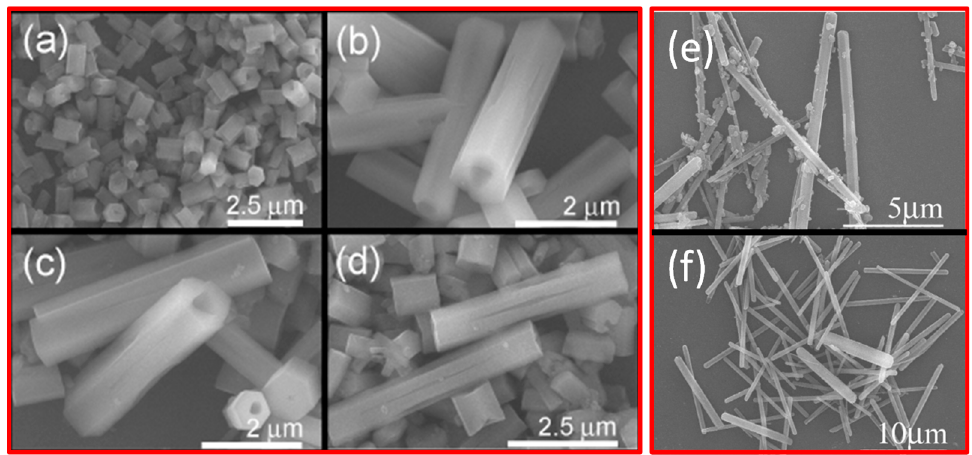
Figure 19. SEM images of fullerene C 60 assemblies (tubes and rods) growing at very early stages. Initially, the C 60 self-organize into nanoparticles, when the formation process of C 60 1D structure is stopped by fast diluting the system into abundant ethanol ( a ). C 60 tubes growing at two seconds after the self-assembly initiation ( b ), ( c ), ( d ). Sample of the C 60 (concentration of 1.0 mg/mL and isopropanol/m-xylene volume ratio of 1:1) obtained in the absence of surfactant (showing irregular rods and small seeds) ( e ), and with the surfactant cetyltrimethylammonium bromide (CTAB) at concentration of 0.5 mM (showing rods with poor uniformity) ( f ). Adapted with permission from Reference [229]. Copyright (2007) American Chemical Society.